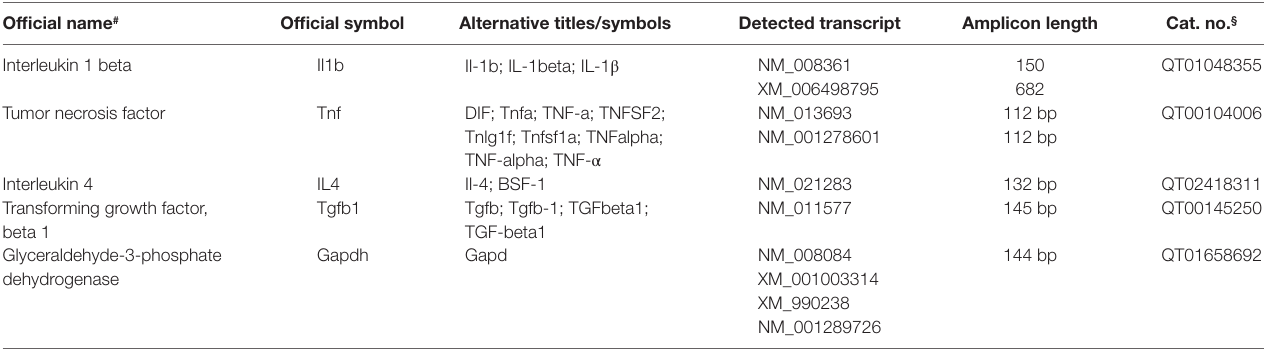
TABLE 1 | List of primers used for quantitative real-time PCR